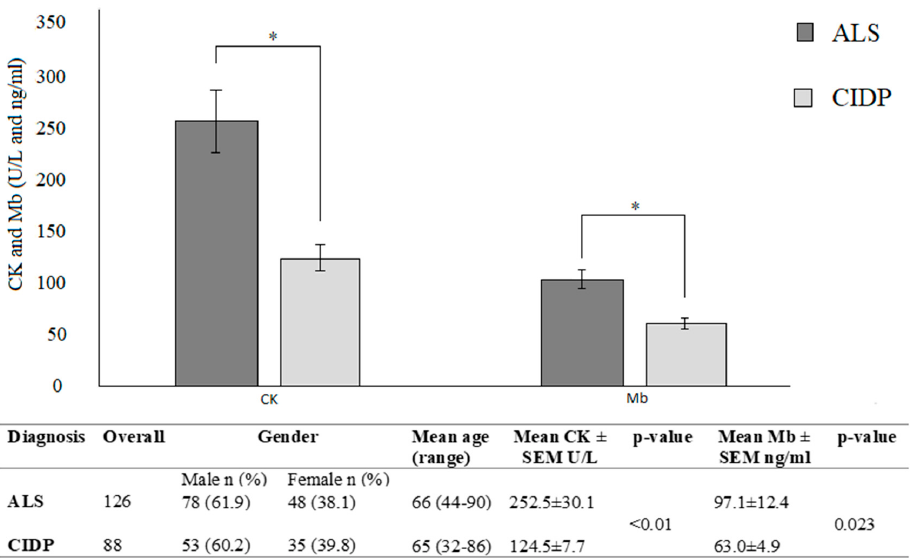
Figure 3. Mean CK and Mb in ALS patients vs Chronic inflammatory demyelinating polyradiculoneuropathy (CIDP)